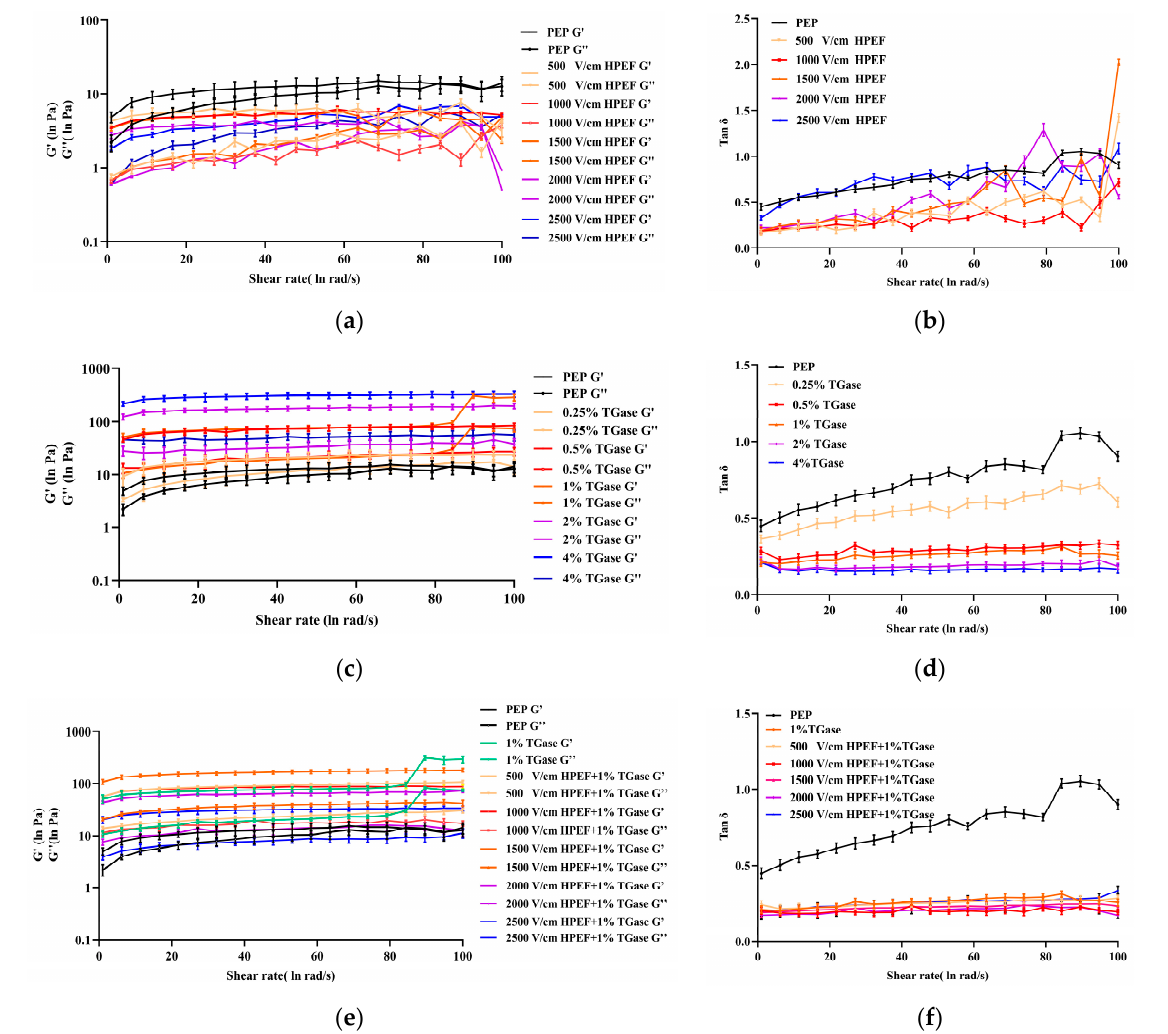
Figure 7. The effects of HPEF (500, 1000, 1500, 2000, and 2500 V/cm), TGase (0.25, 0.5, 1, 2, and 4%), and compound treatment (HPEF-500, 1000, 1500, 2000, 2500 V/cm; 1% TGase) on the G’/G” and tan δ of PEP. ( a ): The G’/G” of PEP treated with HPEF (500, 1000, 1500, 2000, and 2500 V/cm); ( b ): The tan δ of PEP treated with HPEF (500, 1000, 1500, 2000, and 2500 V/cm); ( c ): The G’/G” of PEP treated with TGase (0.25, 0.5, 1, 2, and 4%); ( d ): The tan δ of PEP treated with TGase (0.25, 0.5, 1, 2, and 4%); ( e ): The G’/G” of PEP treated with HPEF and TGase (HPEF-500, 1000, 1500, 2000, 2500 V/cm; 1% TGase); ( f ): The tan δ of PEP treated with HPEF and TGase (HPEF-500, 1000, 1500, 2000, 2500 V/cm; 1% TGase).